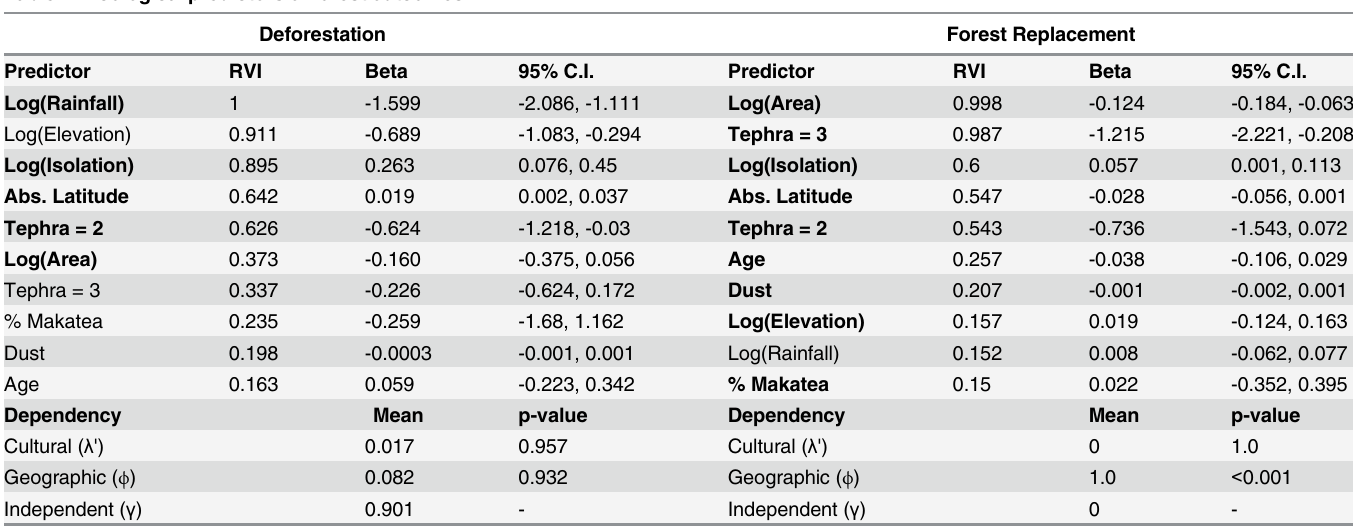
Table 1. Ecological predictors of forest outcomes.